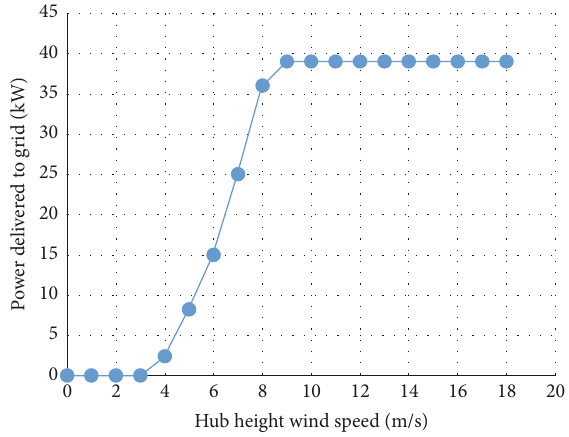
Figure 1: Power curve of IEC 61400-12